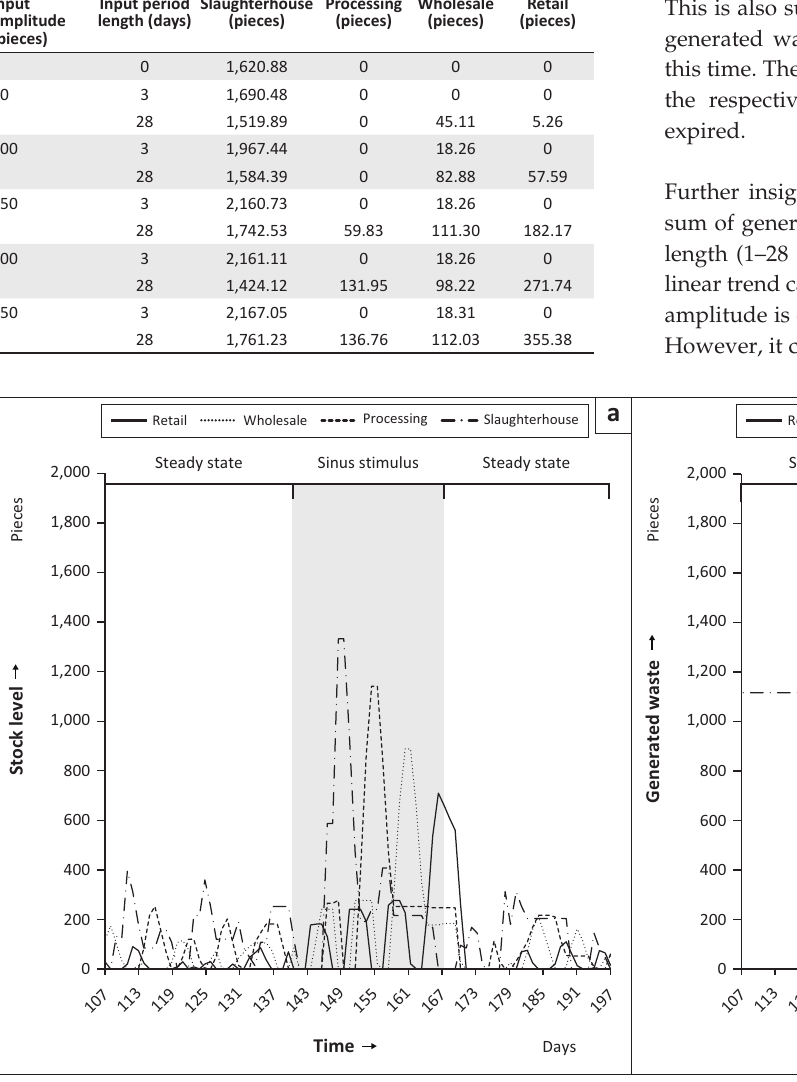
FIGURE 5: Development of (a) stock levels and (b) generated waste before and after a 28-days sinusoidal stimulus.